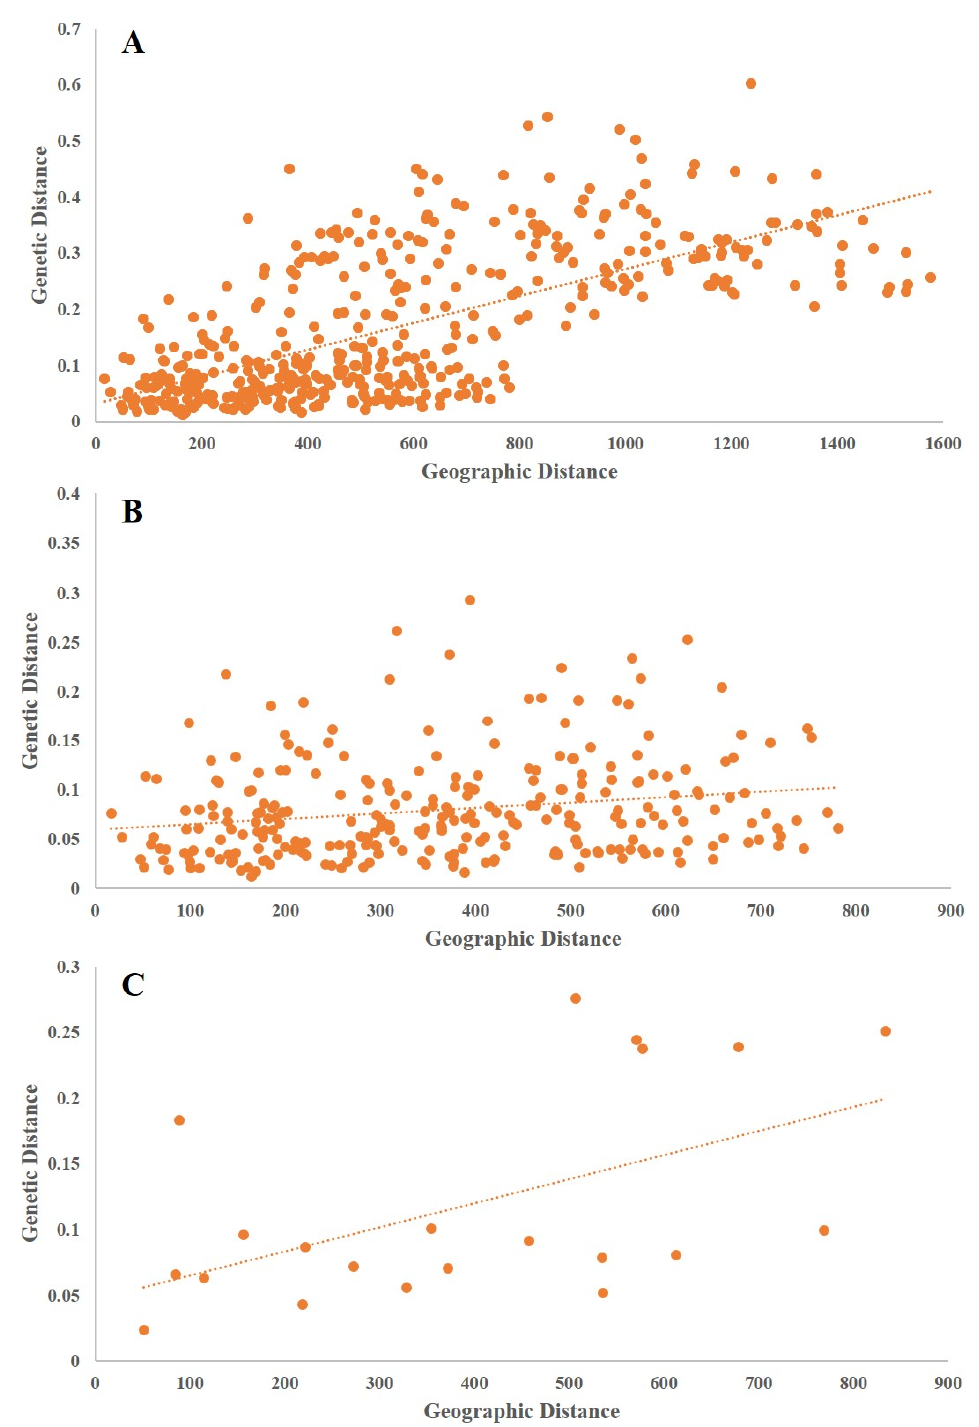
Figure 5. Results of Mantel test between genetic matric and distance matric in L. tibetica . ( A ) Mantel test on all populations, R 2 = 0.6702, p = 0; ( B ) Mantel test on the northern branch populations, R 2 = 0.2018, p = 0012; ( C ) Mantel test on the southern branch populations, R 2 = 0.5324, p = 0.004.